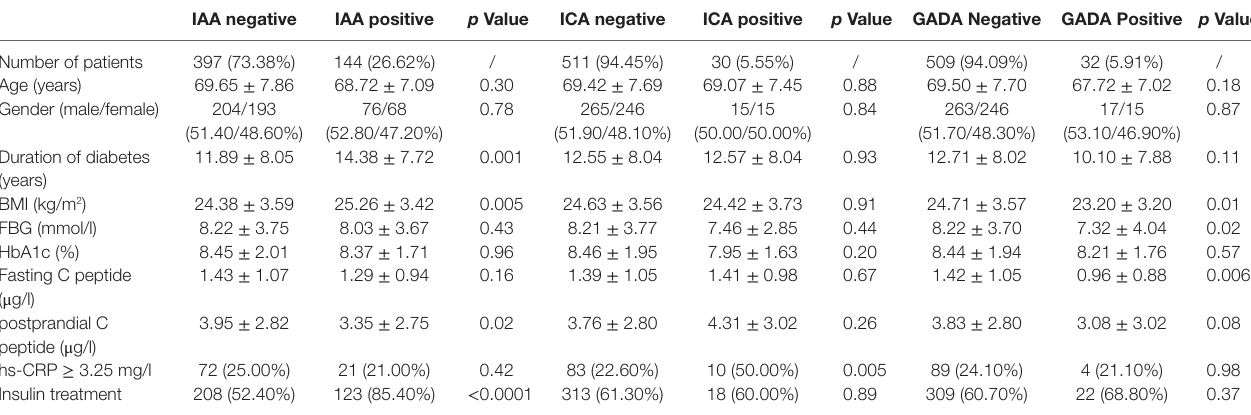
TaBle 2 | Clinical and biochemical characteristics of each group of subjects in type 2 diabetes aged 60 and